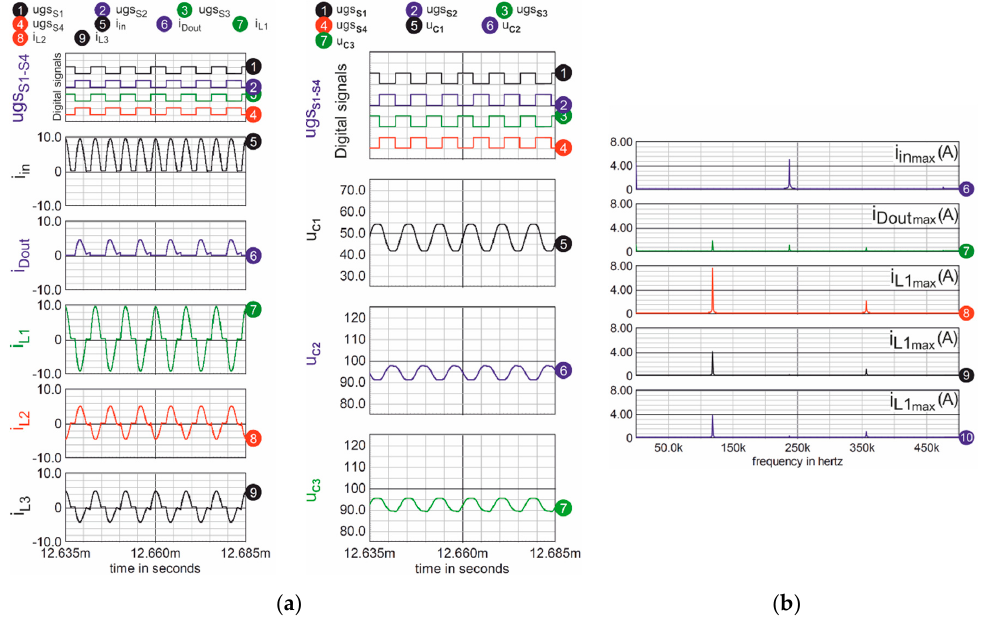
Figure 5. Steady-state operation of the LCSCVMa converter under switching strategy C3: ( a ) waveforms of the gate to source signals of transistors (presented with level shift), input current (in amperes), and voltages (in volts) on capacitors C 1 , C 2 , and C 3 . ( b ) Spectrum of the input current, and currents of switched capacitors and output capacitor. The results were obtained with the use of ICAP / 4 simulation